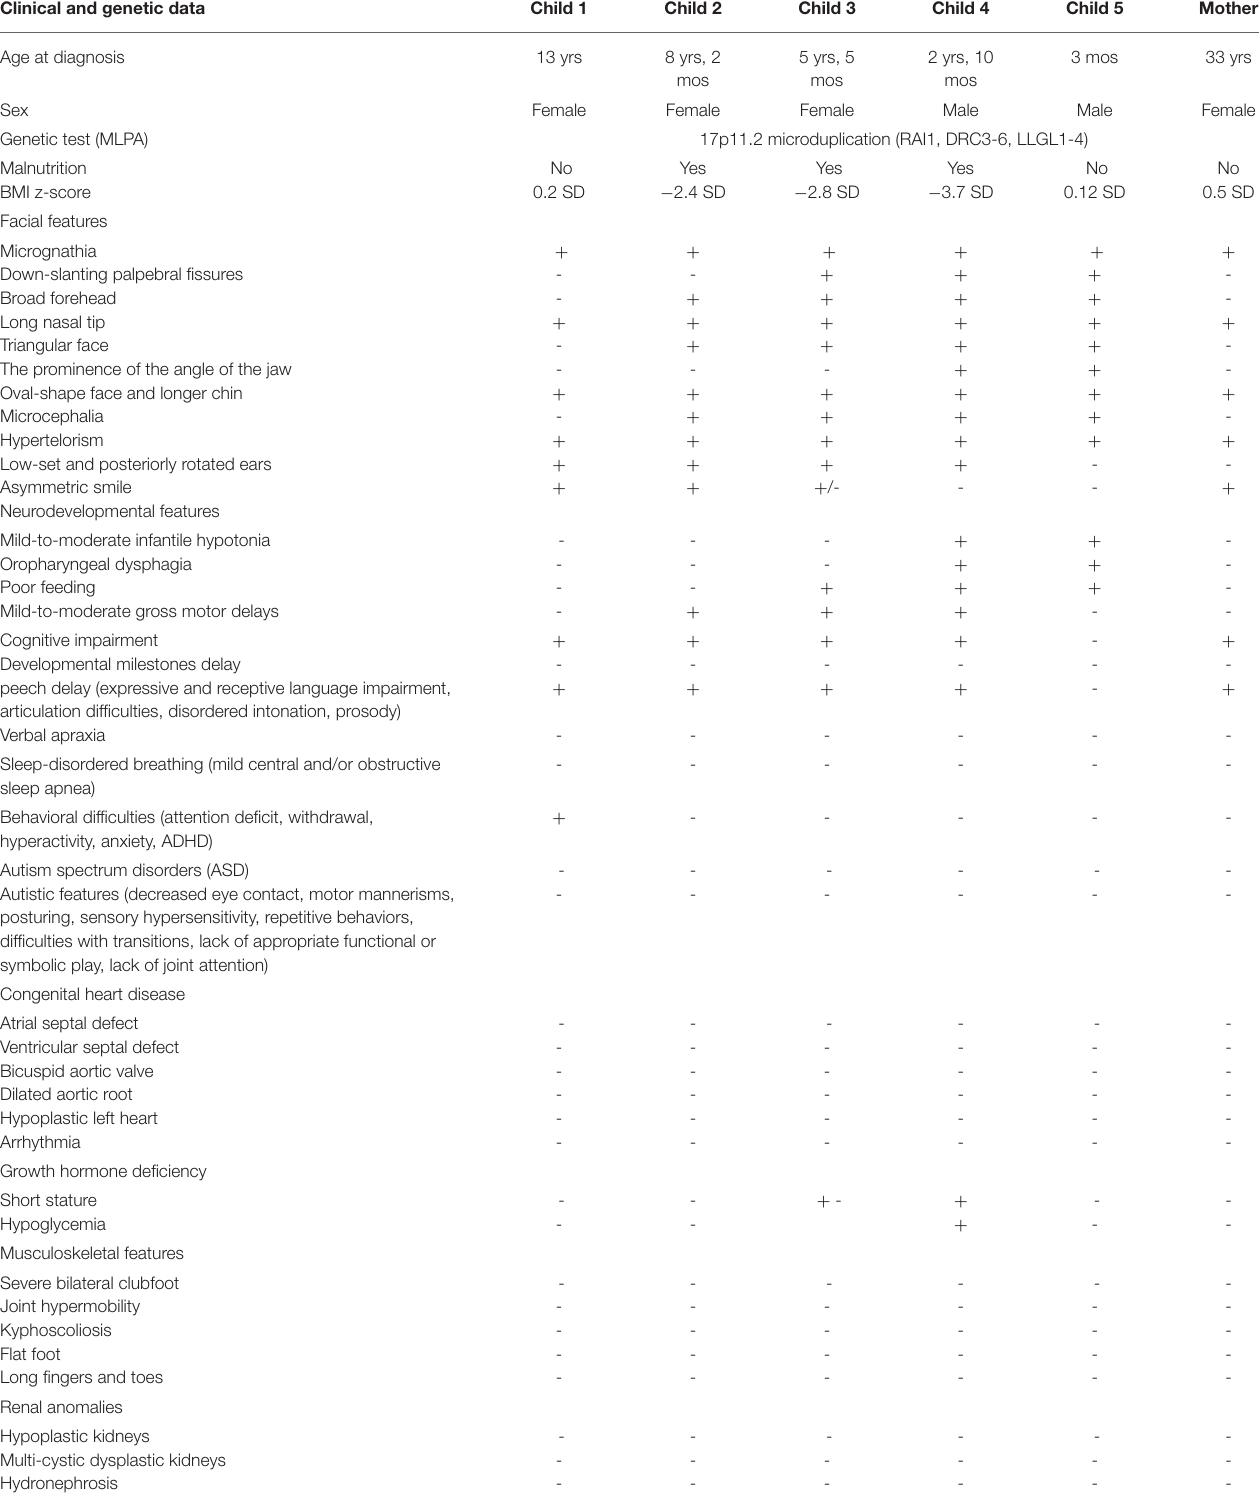
TABLE 1 | Clinical and genetic data of the reported family compared to reported features in children with Potocki-Lupski syndrome (1–10). Clinical and genetic